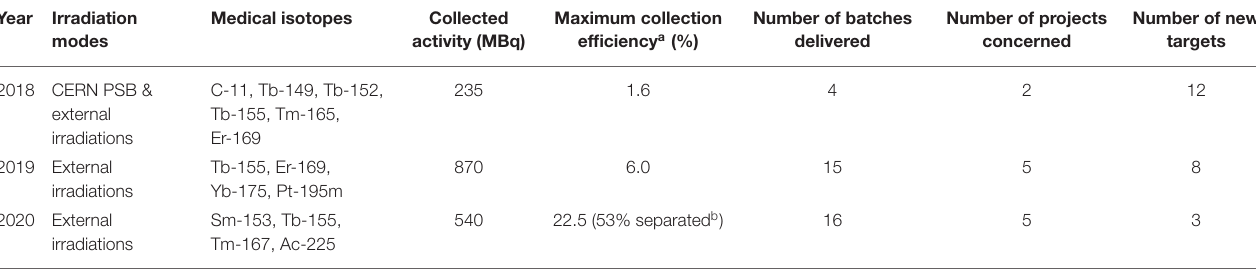
TABLE 3 | Summary of the collections performed at CERN-MEDICIS in 2018, 2019 and